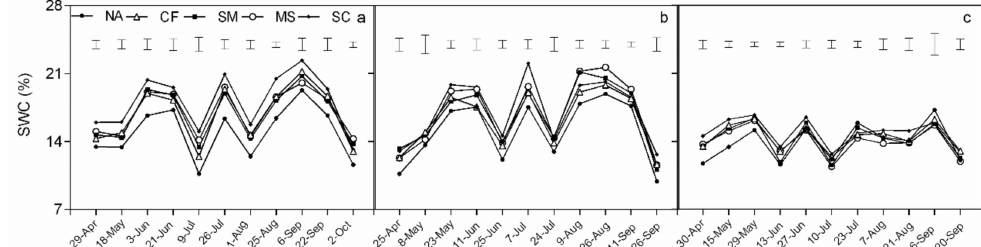
Figure 4. Volumetric Soil water content (SWC) in the 0–10 cm layer during the 2014 ( a ), 2015 ( b ), and 2016 ( c ) growing seasons as influenced by soil amendment treatment. NA, no amendment; CF, chemical fertilizer; SM, swine manure; MS, maize stover; and SC, swine manure + chemical fertilizer. Vertical bars denote LSD (0.05).